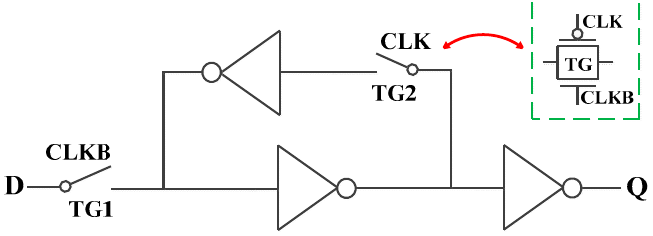
Figure 1. Schematic of the traditional latch. The switch is the symbol of the transmission gate (TG). When CLK = 1 and CLKB = 0, TG1 is turned on, and TG2 is turned off. When CLK = 0 and CLKB = 1, TG1 is turned off, and TG2 is turned on.